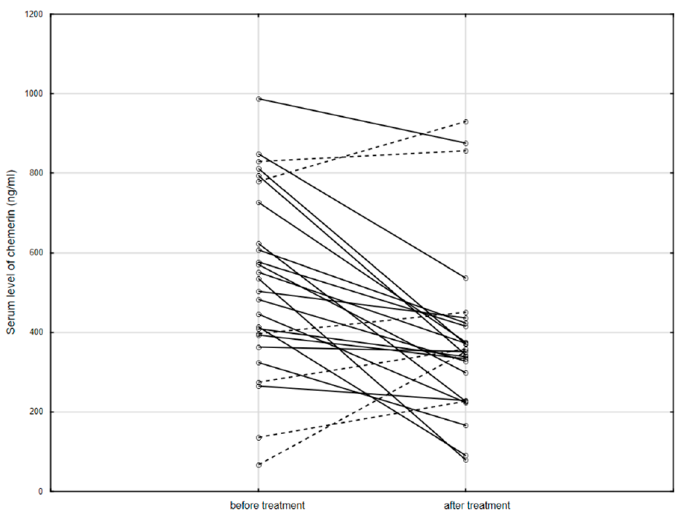
Figure 1. The correlation between chemerin concentration and the Harvey–Bradshaw index results (r = 0.478, p = 0.001) in CD patients. HBI: Harvey–Bradshaw index.